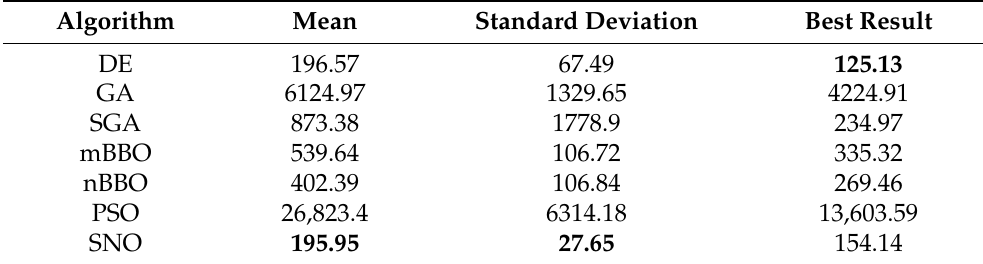
Table 3. Numerical results of the comparison between different EAs. In bold the best values.